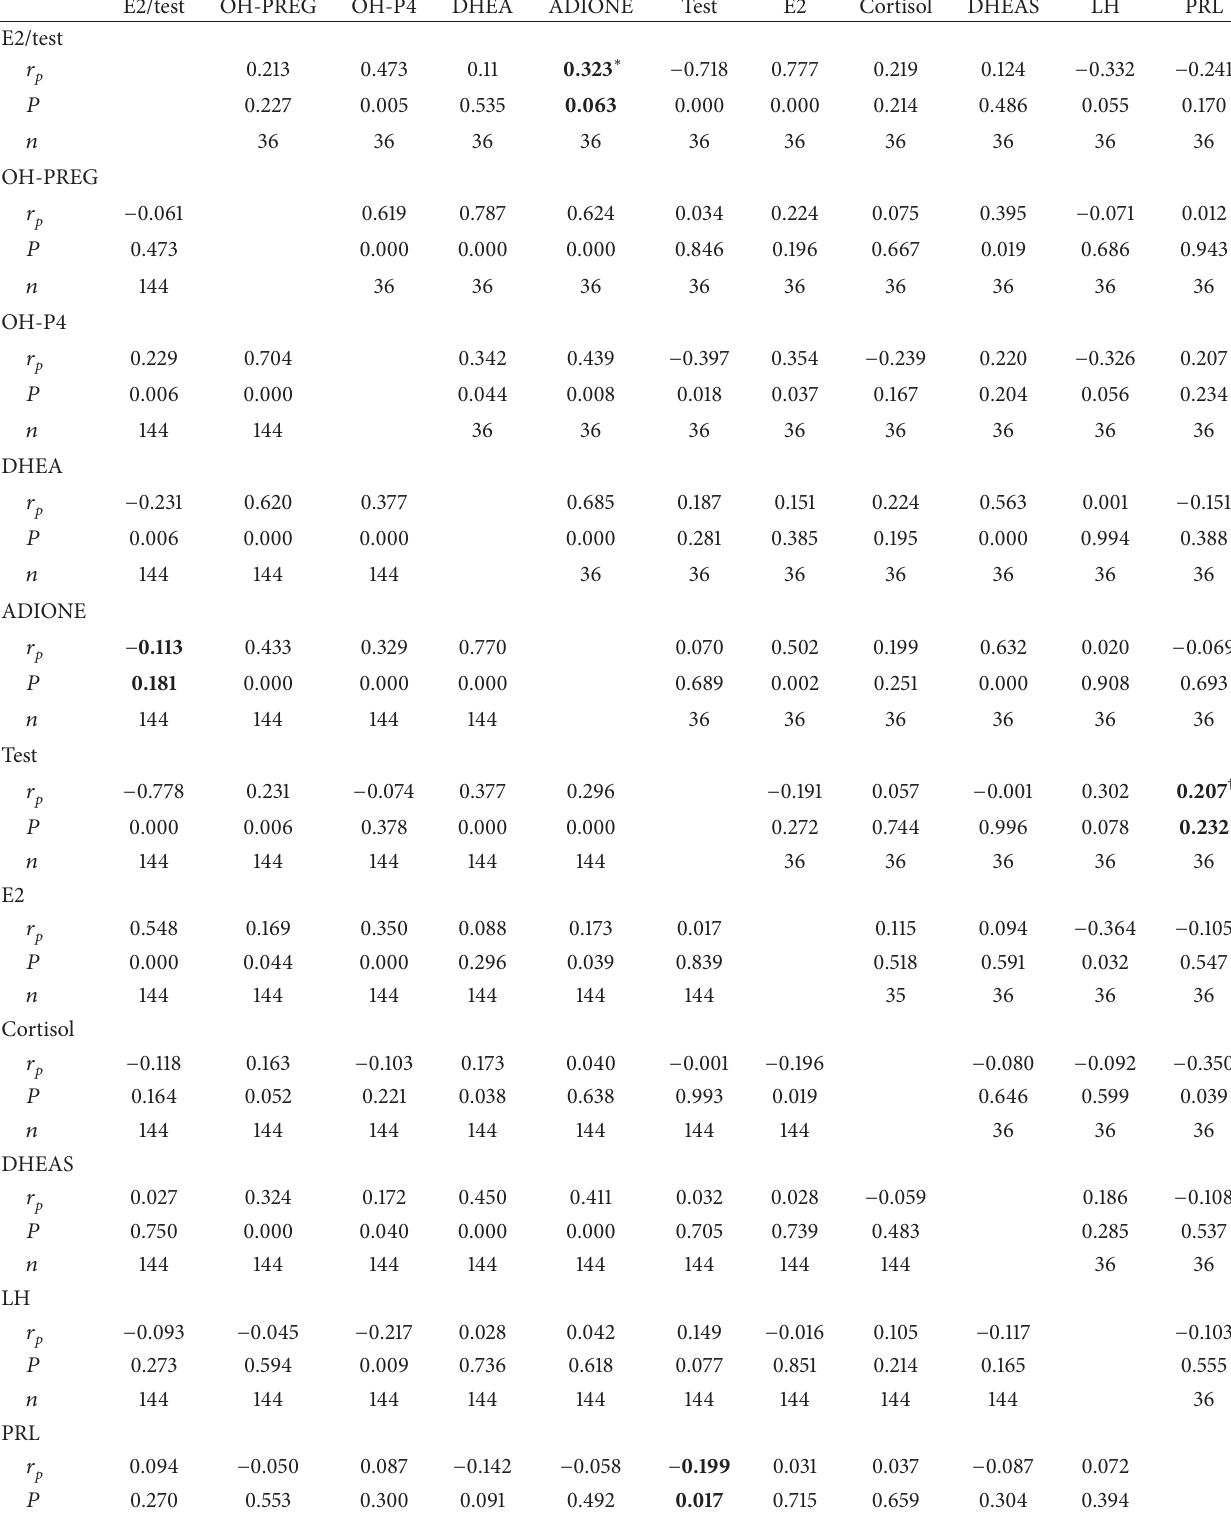
Table 3: Age-adjusted partial correlations of normalized imputed hormones (logs) in female pre-RA (top) and CN (bottom) ∗